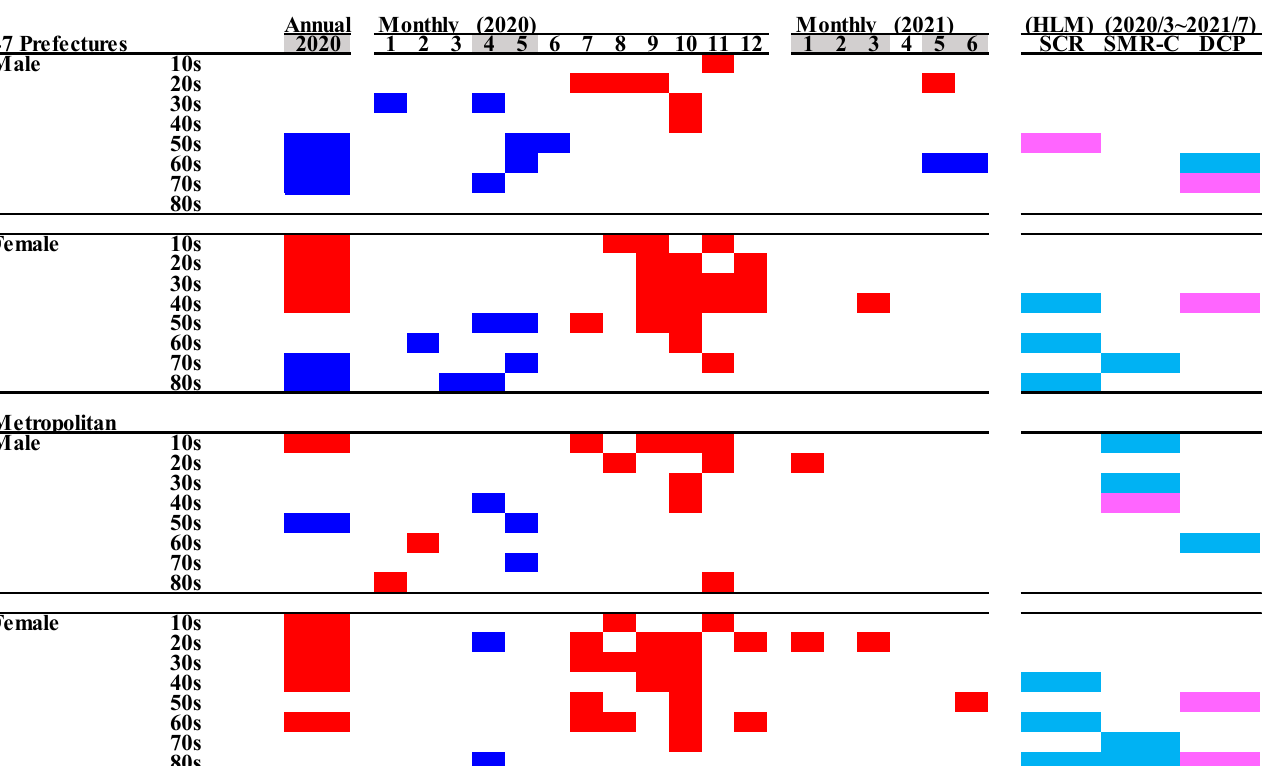
Figure 5. Comparison of annual and monthly SMR-S disaggregated by age during the pandemic period compared to the average SMR-S of the same month during the pre-pandemic period, and impact of COVID-19 pandemic on SMR-S in Japan. Blue and red columns indicate significant decreasing and increasing suicide mortality using a linear mixed-effects model with Tukey’s multiple comparison ( p < 0.05). Light blue and red columns indicate significant decreasing and increasing factors against SMR-S using hierarchical linear model with robust standard error ( p < 0.05). SMR-S: standardised suicide mortality per 100,000 people. SCR: standardised infection with COVID-19 per 100,000 people. SMR-C: standardised mortality caused by COVID-19 per 100,000 people. DCP: during COVID-19 pandemic.